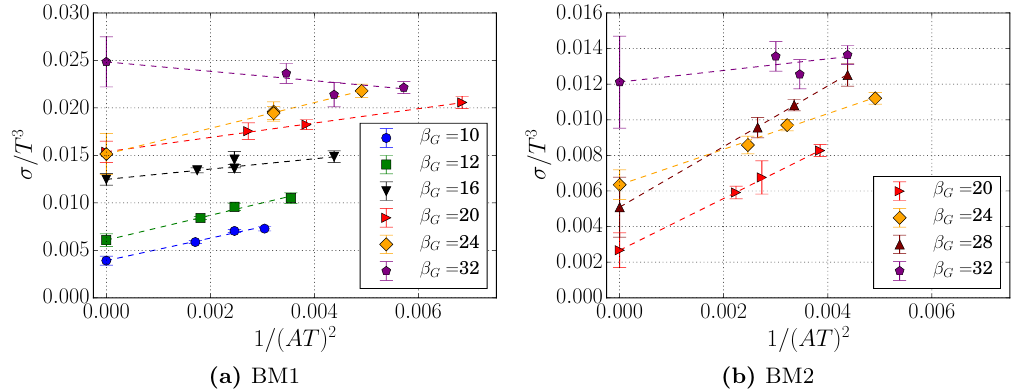
Figure 8. Extrapolation of the surface tension to an in(cid:12)nite surface area. Statistical errors are substantial in the (cid:12) G = 32 case and could be improved with more